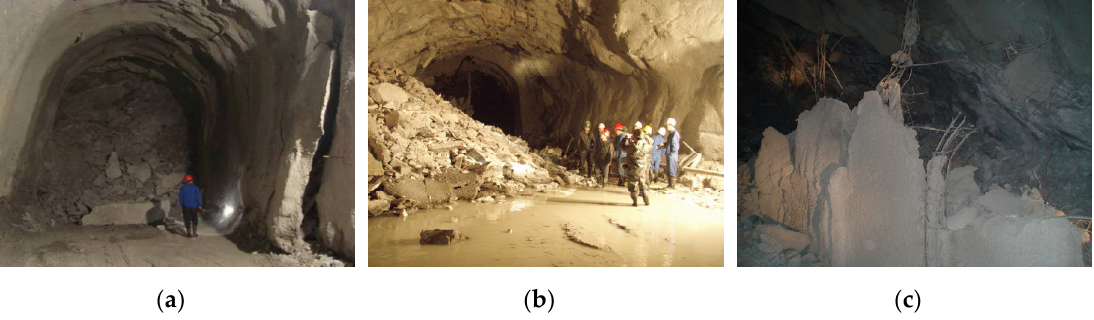
Figure 12. Rockburst in auxiliary tunnels: ( a ) Extremely strong rockburst; ( b ) Induced collapse; ( c ) Support structure damage.